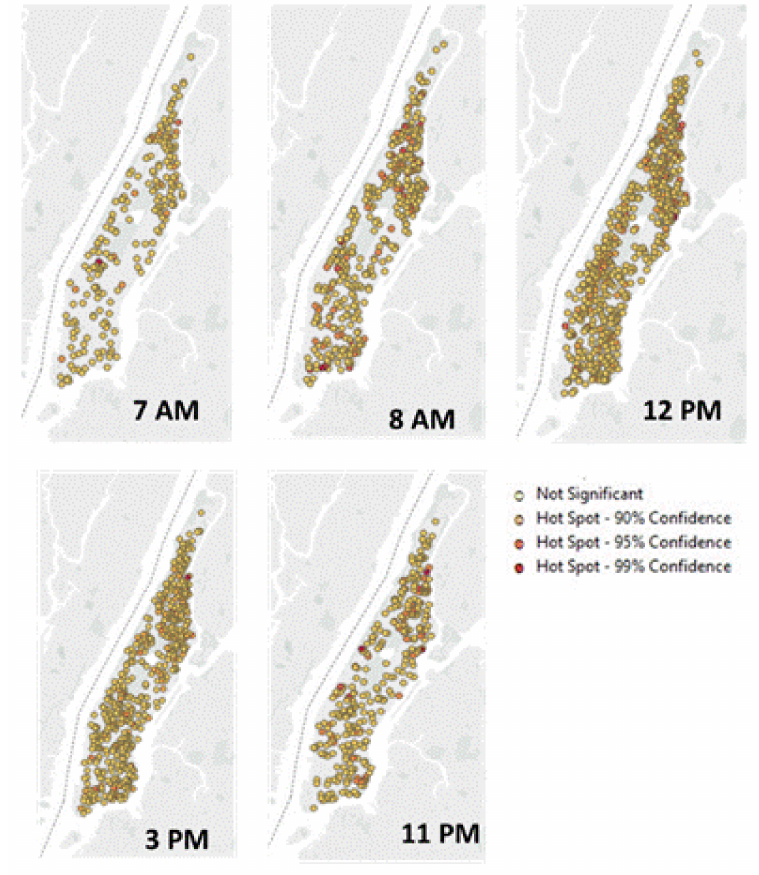
Figure 2. Hot spots of assaults committed in Manhattan, NY. Location of assaults and their intensity demonstrate that hot spots “move” within Manhattan depending on the time when the assault was committed. At 7 a.m. there is one statistically significant hot spot (at a 99% confidence level) in Midtown and one in Uptown, whereas, at 11 p.m. (peak time for assaults) there are four statistically highly significant hot spots in Midtown, and a couple in both Uptown and Downtown